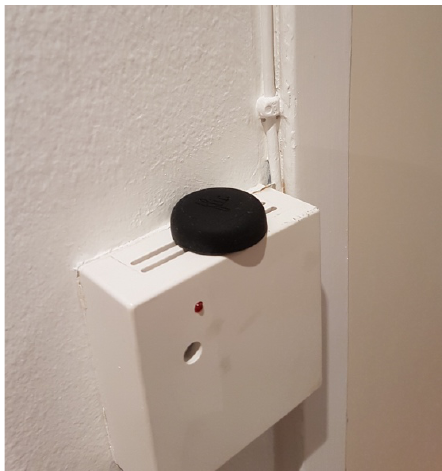
Figure 4 . A Button placed on a thermostat on the way to the